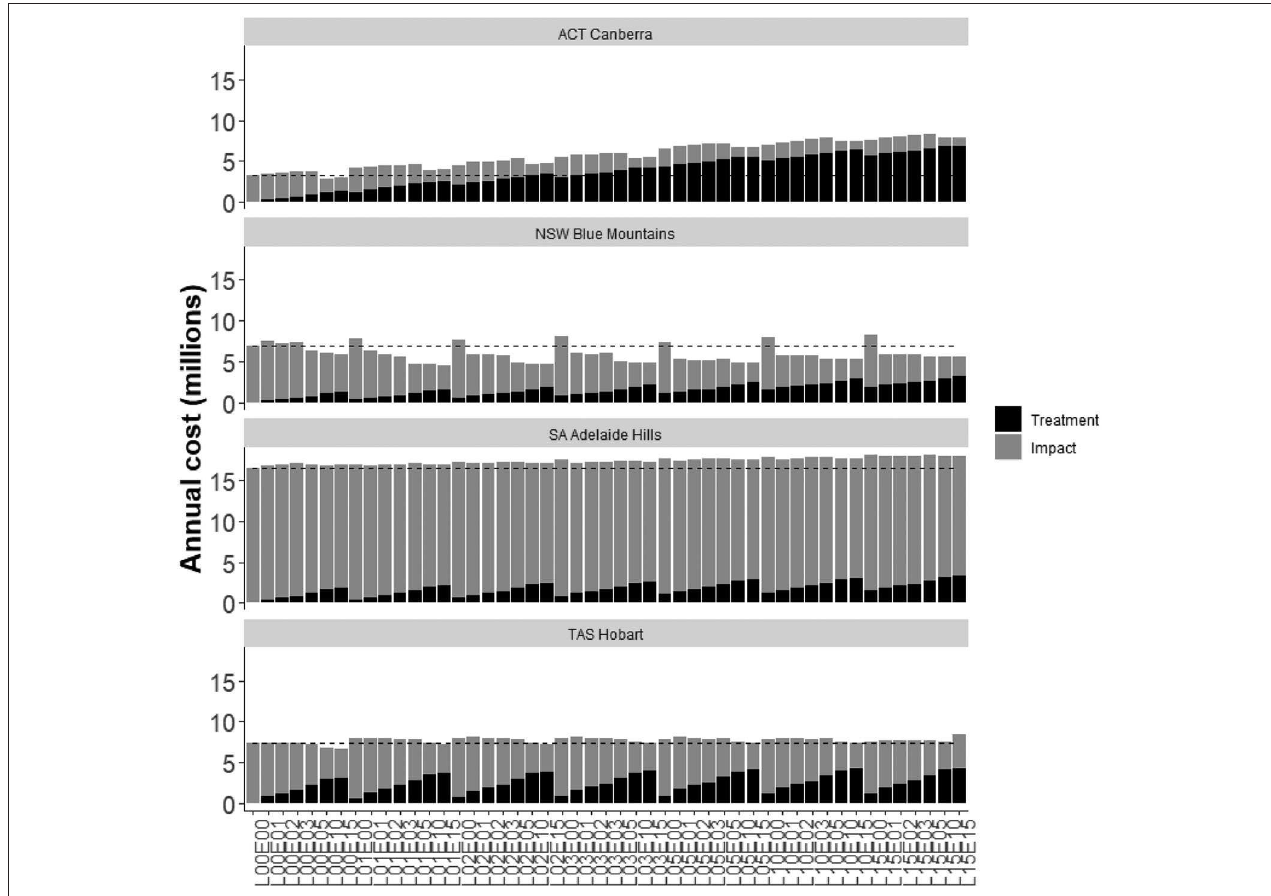
FIGURE 5 | Annualized risk costs for four case study regions across all treatment rates. The dashed line represents the do nothing approach—columns below this line are considered cost-effective. Treatment codes are presented as LXXEYY where XX represents the annual prescribed burning treatment rate in the landscape and YY the rate in the edge